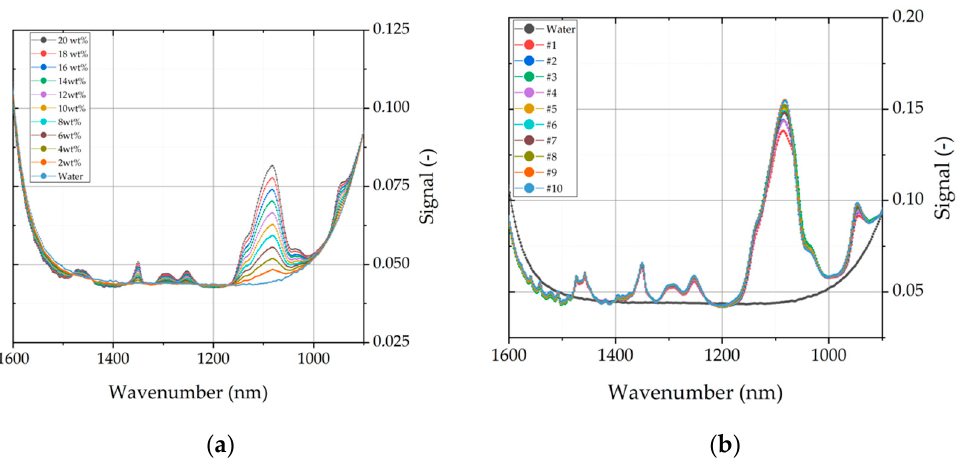
Figure 12. Calibration of the model varying dilutions of PEG 400 and PEG 4000 as training set for buildup of the predictive model. ( a ) Calibration set of PEG 4000 with increasing PEG content (2–20 wt%). ( b ) Second calibration curve of a mixture consisting of PEG 400 and PEG 4000. PEG 400 content increased from 2 wt% to 20 wt% and PEG 4000 decreased from 20 wt% to 2 wt%.